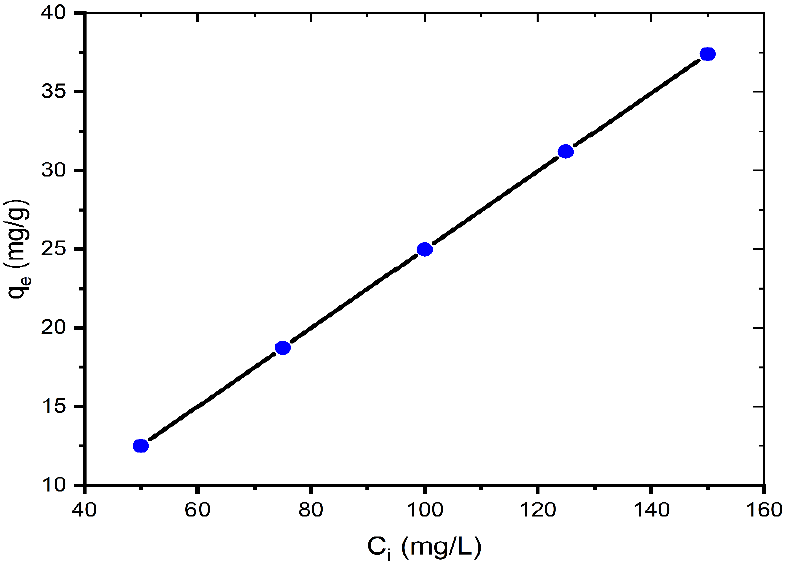
Figure 2. Effect of initial concentration on adsorption of MB onto coal (mass of coal = 0.1 g; volume of MB solution = 25 mL; T = 299.15 K, pH = 6.35).